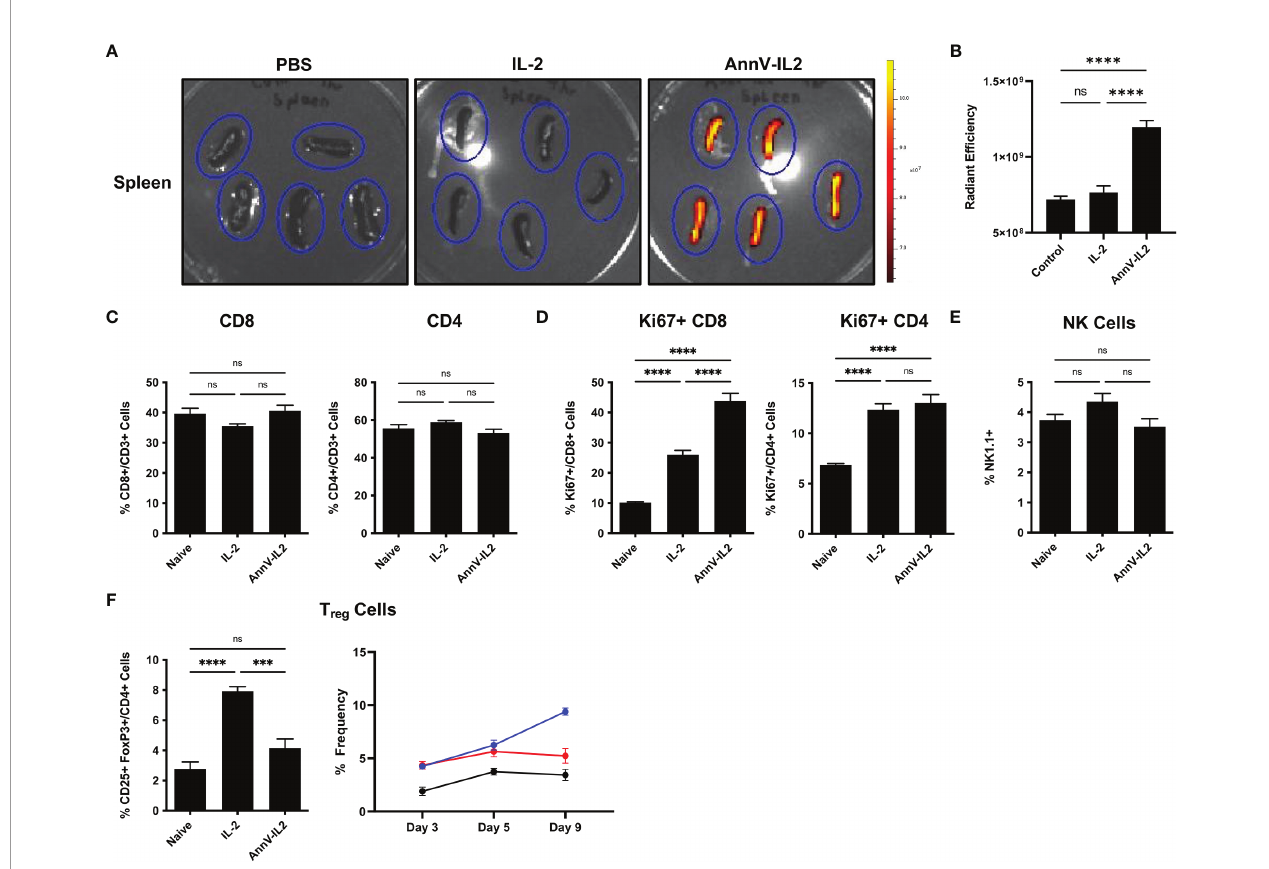
FIGURE 3 | AnnV-IL2 accumulates in the spleen and induces Ki-67 expression in CD8 T cells. (A) Equimolar amounts of Alexa-647 labeled AnnV-IL2 or IL-2 protein was injected intravenously. After 4 hours the spleens were removed and imaged via IVIS imaging. Spleens are outlined in blue ovals, N=5 mice per group. (B) Quanti fi cation of fl uorescence signal in the spleen (C – F) Mice were intravenously injected with AnnV-IL2, IL-2, or PBS (naive) once daily for 9 days total. PBMC ’ s were collected on day 9 and analyzed by fl ow cytometry. N=5 mice per group. Data is represented by mean ± SEM. P values were calculated by ordinary one-way ANOVA with the Tukey-Kramer multiple comparison test, and P < 0.05 is considered statistically signi fi cant. *** = < 0.001, **** = < 0.0001. NS, not signi fi